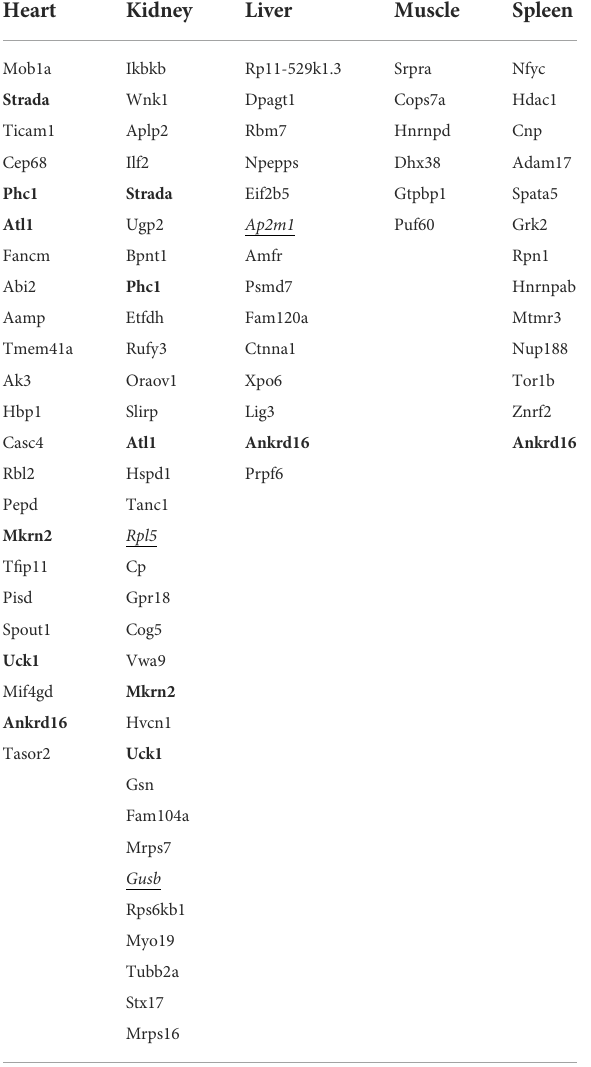
TABLE4Moststablyexpressedgenesof fi vechickentissuesthatarein common between the top 100 genes of the training dataset and the top 100 genes of the evaluation